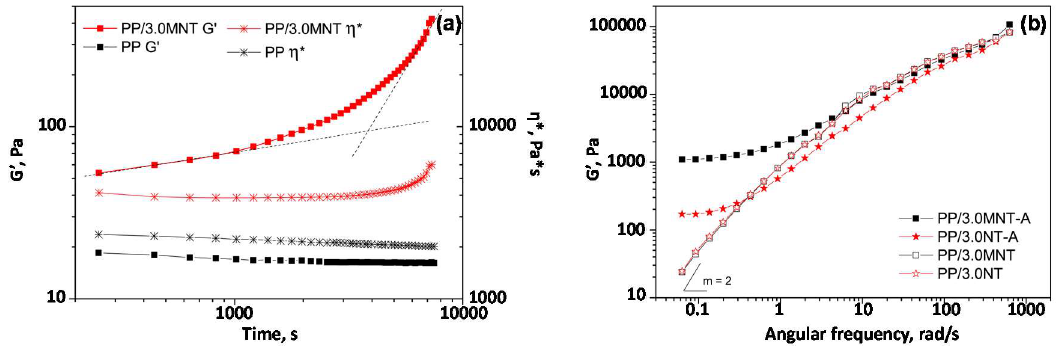
Figure 5. Time evolution of storage modulus and complex viscosity ( a ), and storage modulus as a function of frequency ( b ) for polypropylene (PP)-based nanocomposites (NT: pristine MWCNTs; MNT: surface modified MWCNTs; PP / 3.0NT-A and PP / 3.0MNT-A: PP-based composites containing pristine and modified MWCNTs, respectively, subjected to annealing). Adapted with permission from [72]. Copyright (2014) Elsevier.